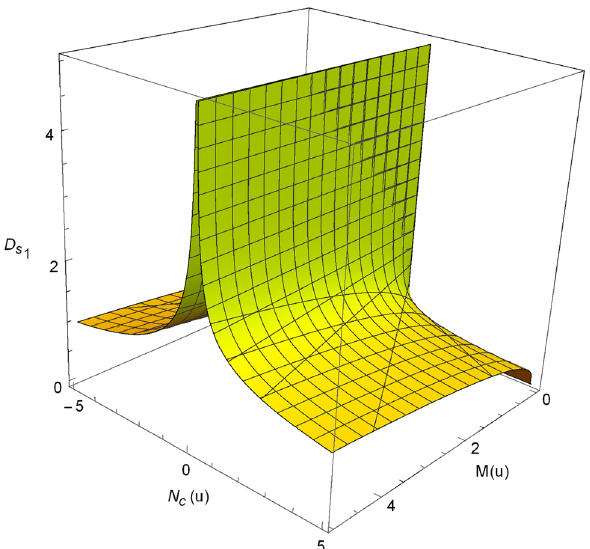
Fig. 16 The variation of D s versus typical values of the M ( u ) and 1 N c ( u ) parameters for the cosmological background